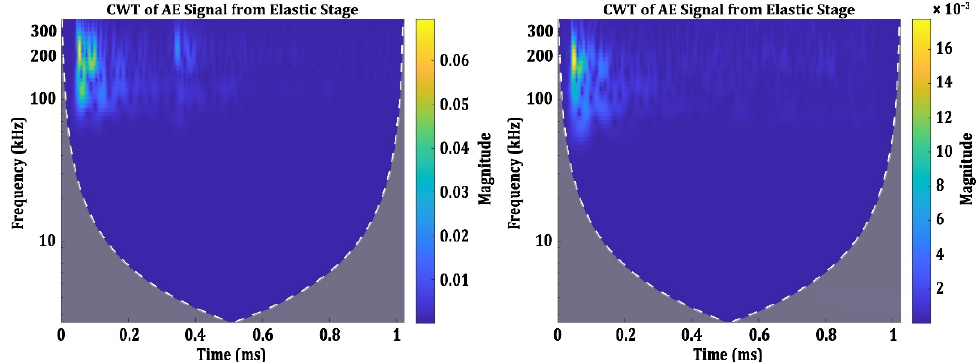
Figure 6. CWT Spectrograms of the AE signals from the elastic stage.